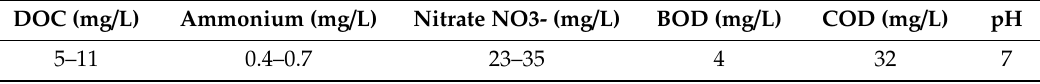
Table 3. Characterization of TWW used in the experiments with measured ranges of dissolved organic carbon (DOC), ammonium and pH. Biochemical oxygen demand (BOD) and chemical oxygen demand (COD) were taken from